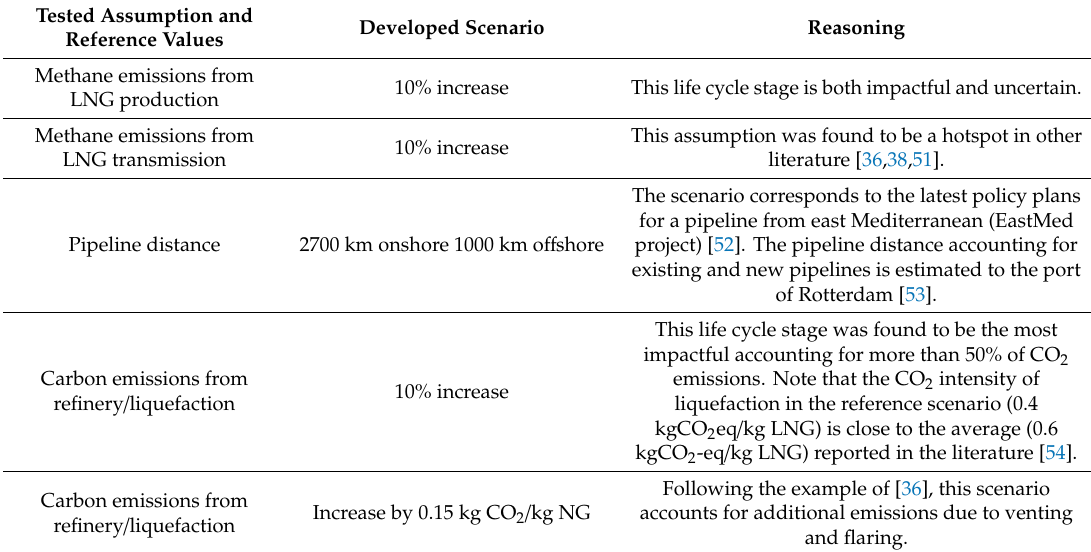
Table 8. Assumptions related to the upstream part of the system that were tested through a scenario analysis.